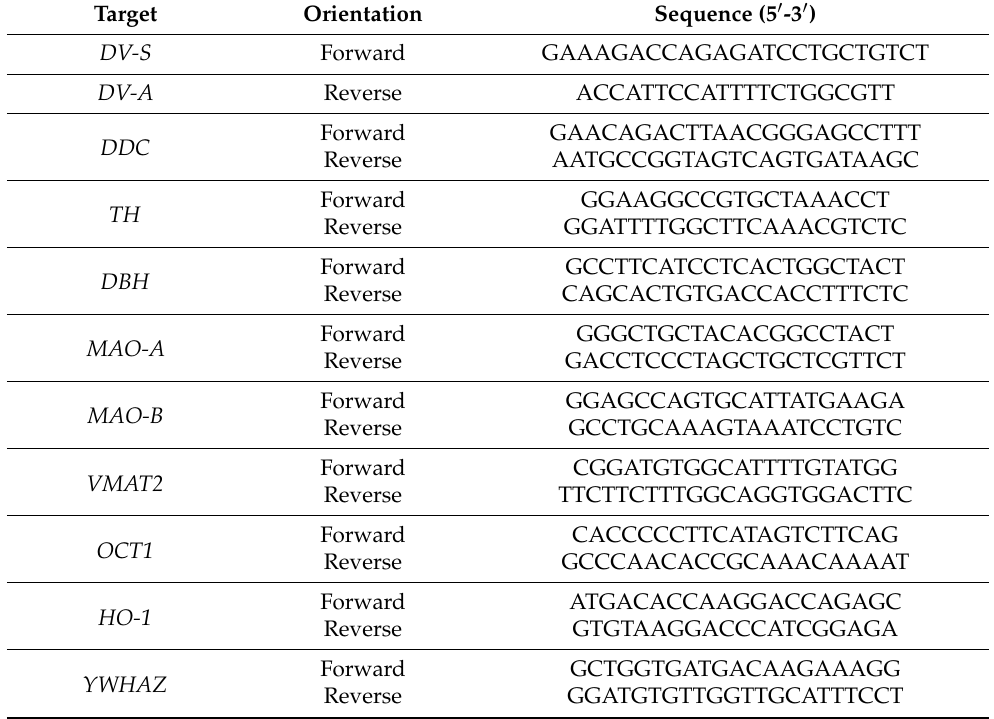
Table 1. Priming oligonucleotides used for RT-qPCR analysis. Target Orientation Sequence (5 (cid:48) -3 (cid:48)